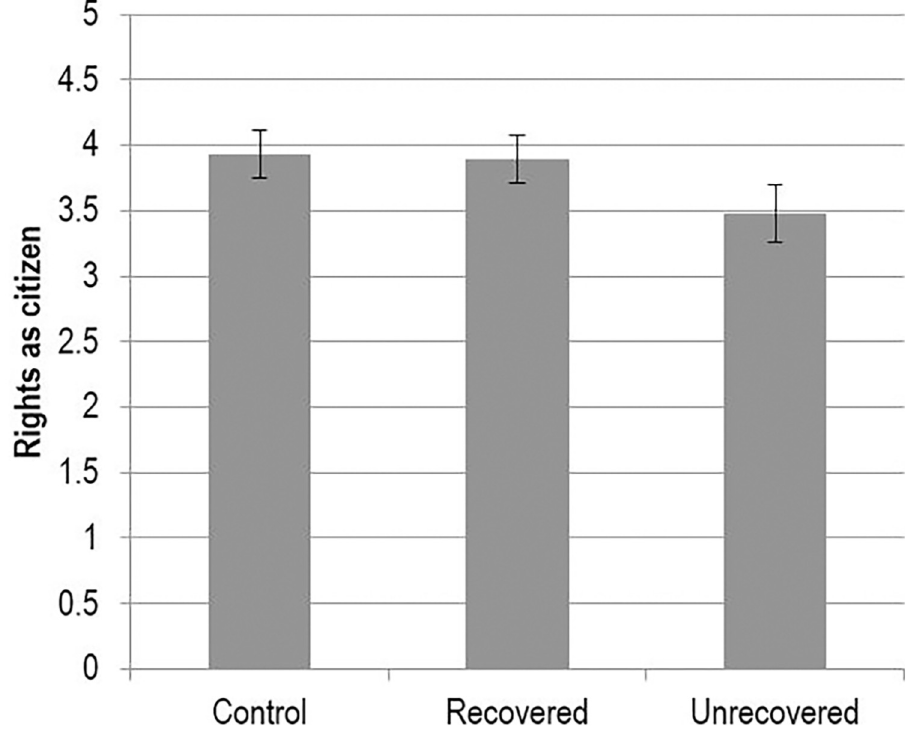
Fig 4. Means scores for rights as citizen measure (+/- 2